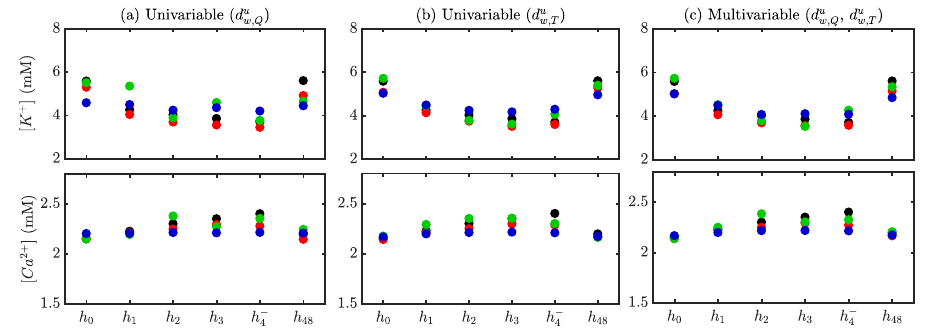
Figure 6. Actual (black) and estimated [ K + ] and [ Ca 2 + ] for a patient using stage-specific (red), patient-specific (green) and global (blue) approaches. Univariable d u (panel a ), d u -based in (panel b ) and multivariable d u w,T